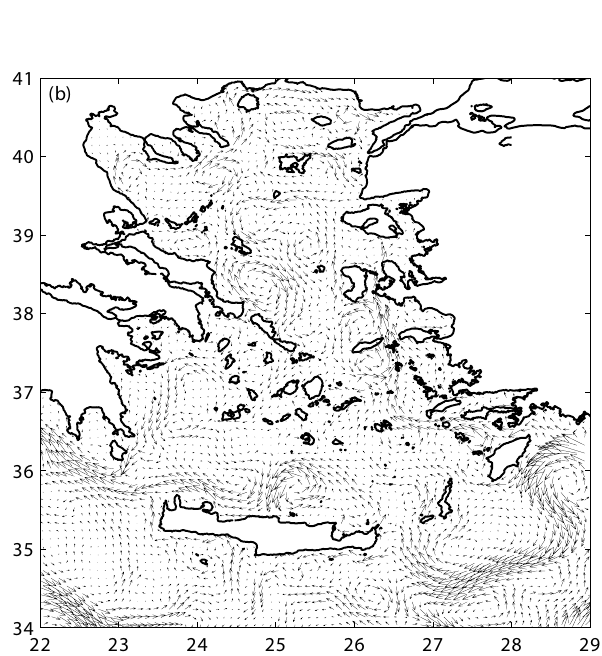
Fig. 15. Aegean Sea subsurface (30m) circulation picture as de- duced from ALERMO’s climatological run: (a) for February and (b) for